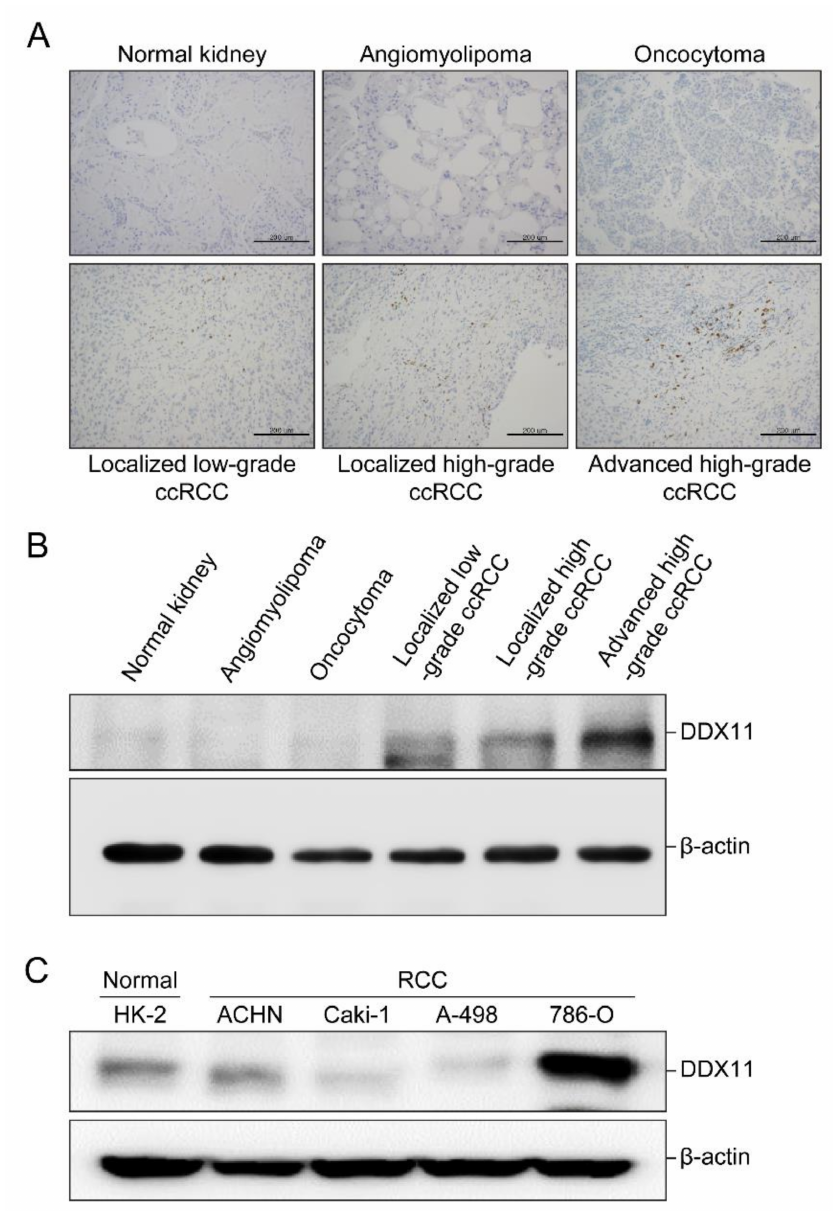
Figure 1. DDX11 expression in normal kidney tissues, benign renal tumors, and renal cell carcinoma (RCC) cell lines and tissues. ( A ) Cryopreserved tissue sections representing normal kidney tissues, benign renal tumors (angiomyolipoma and oncocytoma), localized low-grade clear cell RCC (ccRCC), localized high-grade ccRCC, and advanced high-grade ccRCC were stained with an antibody against human DDX11 and counterstained with hematoxylin. Images were captured at 200 × magnification, Scale bar: 200 µ m. ( B ) Immunoblot representing the expression of DDX11 in normal kidney tissues, benign renal tumors, and ccRCC (localized low- and high-grade ccRCC and advanced high-grade ccRCC) tissues. ( C ) Immunoblot representing the expression of DDX11 in RCC cells (786-O, Caki-1, A-498, and ACHN) and the human proximal tubular cell line (HK-2). β -actin was used as the internal control. Original Western Blots can be found in Figure